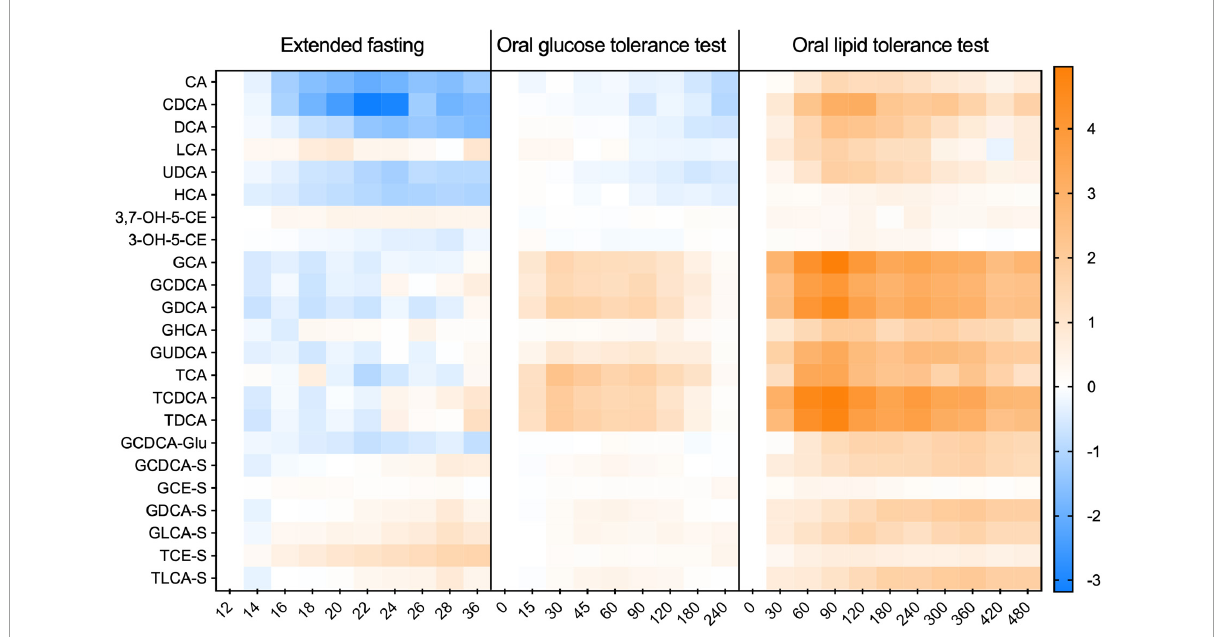
FIGURE1 Kinetic profiles of individual bile acids in plasma during the extended fasting and dietary challenges. The appearance of individual BA species in each challenge expressed as a fold-change from the baseline. Data was Log-2 normalized and presented as mean ± SEM. N = 15 with the X -axis given in